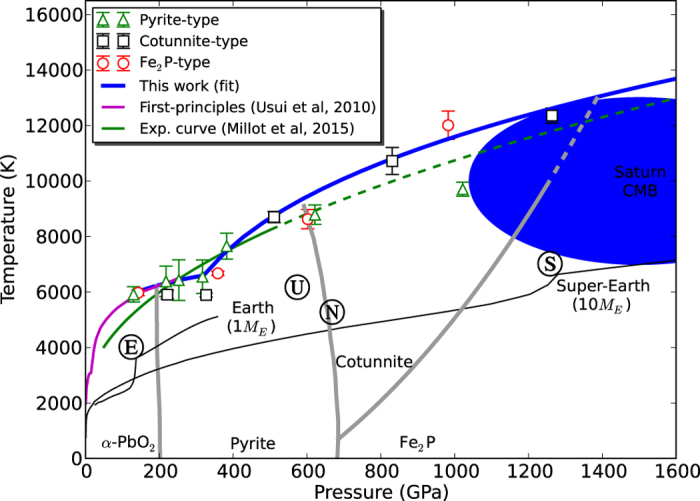
Details of SiO2 melting curve, along with solid-phase boundaries.Symbols are the same as in Fig. 1. Gray lines are predicted solid-phase boundaries from ref. 26 and 27 (dashed when extrapolated). The melting curve of SiO2 obtained from shock experiments23 and from two-phase simulations24 are shown in green and magenta, respectively (dashed when extrapolated).